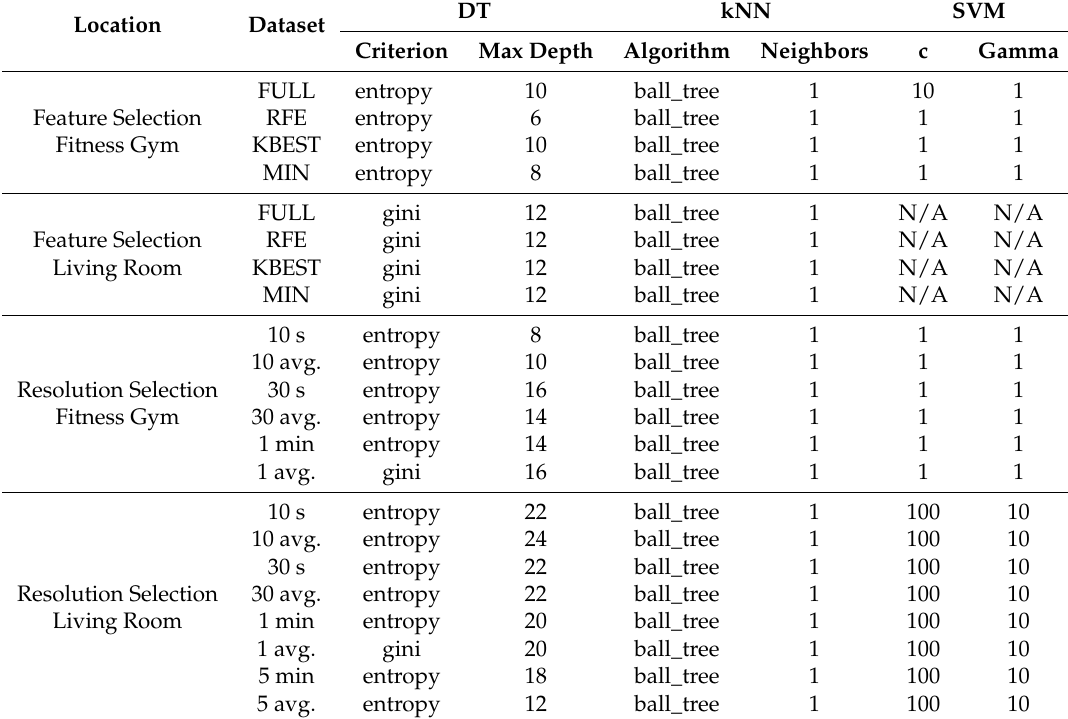
Table 3. Parameters used for Features Selection and Resolution Selection experimentation.